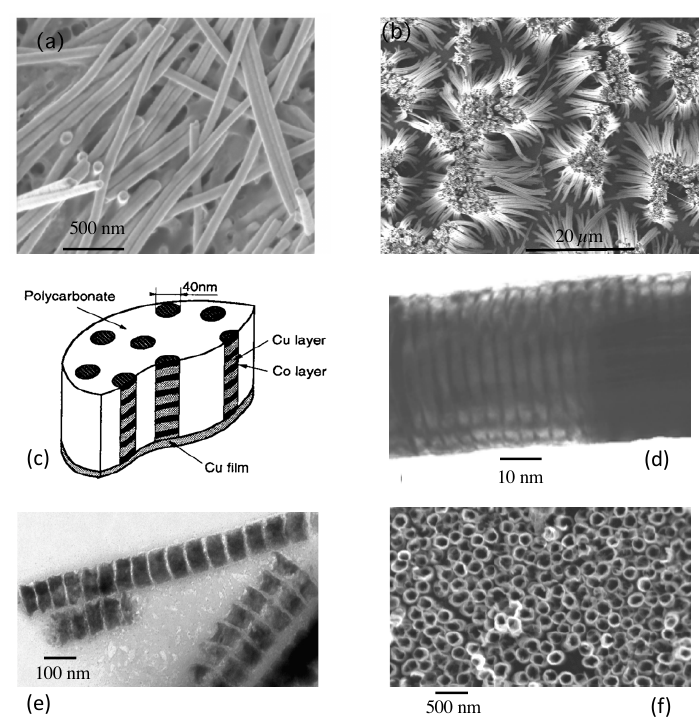
Figure 3. ( a , b ) SEM images of metal nanowires; ( c ) schematic of Co/Cu nanowires embedded in a polymer template; ( d , e ) TEM image of Ni80Fe20/Cu and Co/Cu multilayered nanowires; ( f ) SEM image of Ni